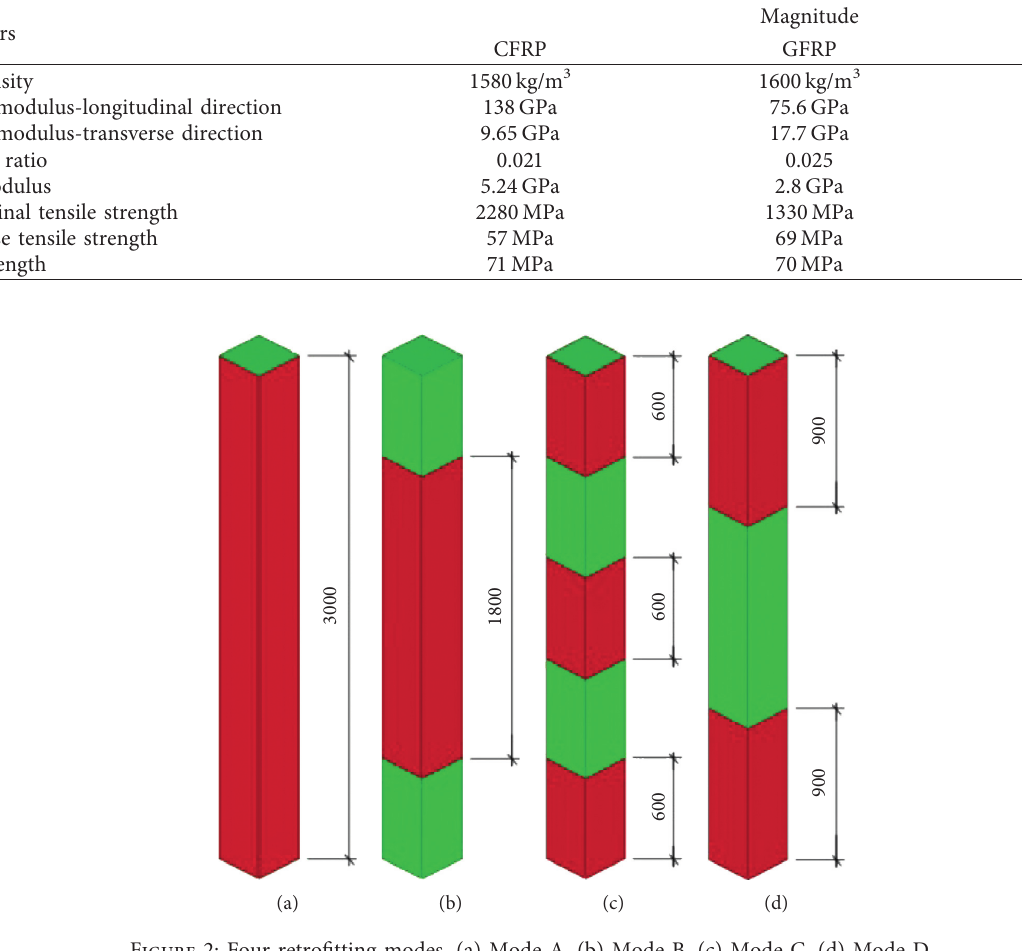
Figure 2: Four retrofitting modes. (a) Mode A. (b) Mode B. (c) Mode C. (d) Mode D.